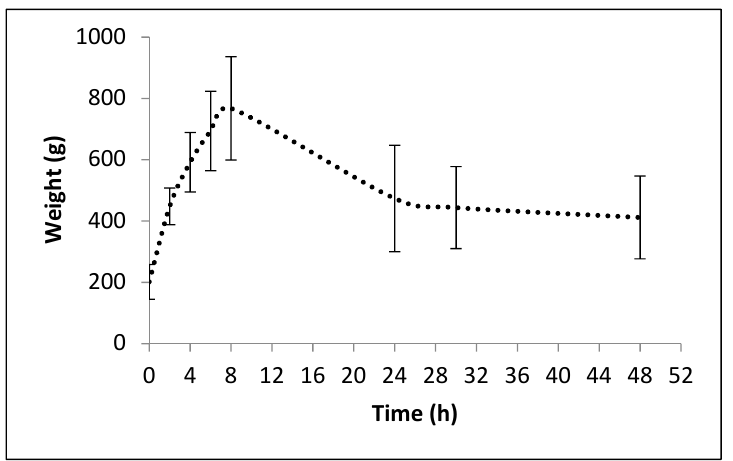
Figure 1. Mulch moisture retention vs. time curve (points represent the average of three replicates and the bars the standard deviation).